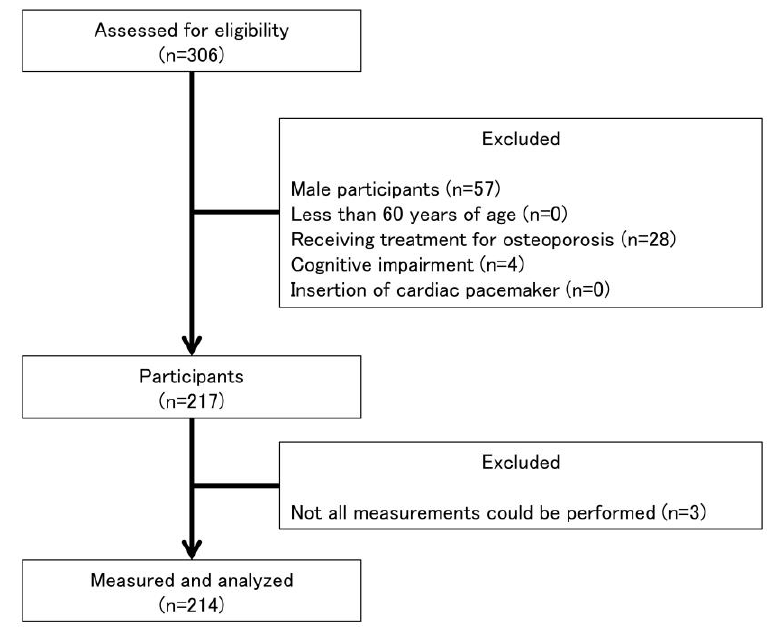
Figure 1. Flowchart of participation criteria.